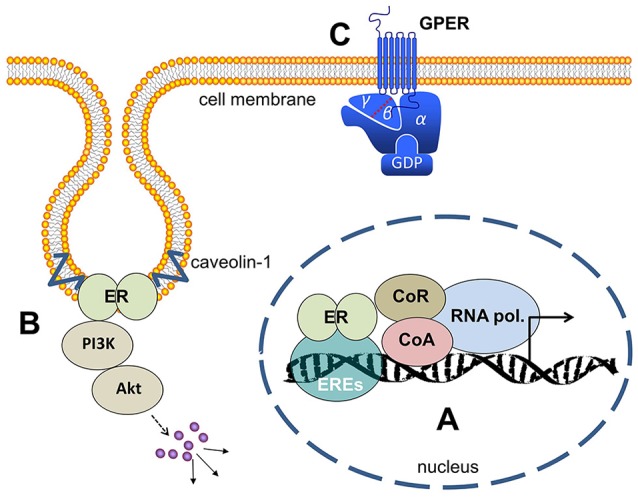
Estrogen receptors (A) ER's (either ERα or ERβ-homodimers, or α/β-heterodimers) bind to the ERE (estrogen responsive elements) in the nucleus and activate gene transcription. (B) At the cell membrane ER's bound to caveolin and activate cytosolic signaling like PI3-kinase/Akt and MAP-kinases. (C) GPER is a membrane-integrated 7-transmembrane receptor activating heterotrimeric G-proteins after estrogen binding and eliciting various signaling pathways as described in the main text. ER, estrogen receptor; ERE, estrogen responsive elements; CoA, co-activator; CoR, co-repressor; PI3K, phosphoinositol-3-kinase; GPER, G-protein coupled estrogen receptor 1; GDP, guanosindiphosphat.